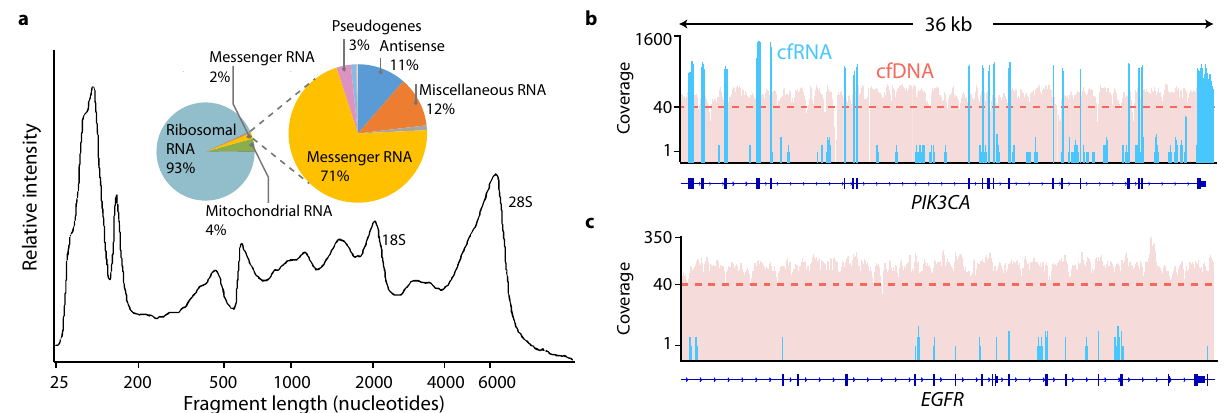
Fig. 1 Analytical characterization of cell-free RNA. a Fragment Analyzer (Agilent) trace of cfRNA fragment lengths in a non-cancer sample following deoxyribonuclease (DNase) digestion. Inset: Relative proportion of different RNA types found by whole-transcriptome sequencing in a representative non- cancer sample prior to abundant transcript depletion. Sequencing coverage across a 36 kb region of b PIK3CA , a high-abundance cell-free RNA gene, and c EGFR , a low-abundance cell-free RNA gene, from a representative patient sample. Blue bars represent coverage for a whole-transcriptome cfRNA sample with 584 M paired-end reads, and red bars represent coverage for a whole-genome cfDNA sample from the same patient with 871 M paired-end reads. The dashed line represents median cfDNA coverage.